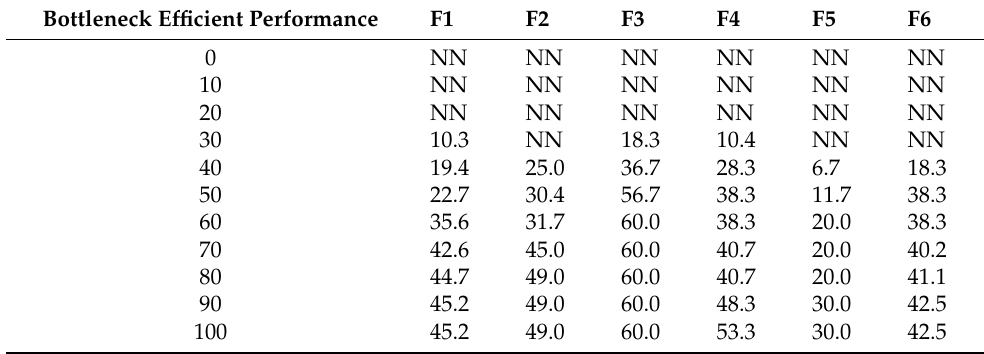
Table 2. Bottleneck table and NCA effect